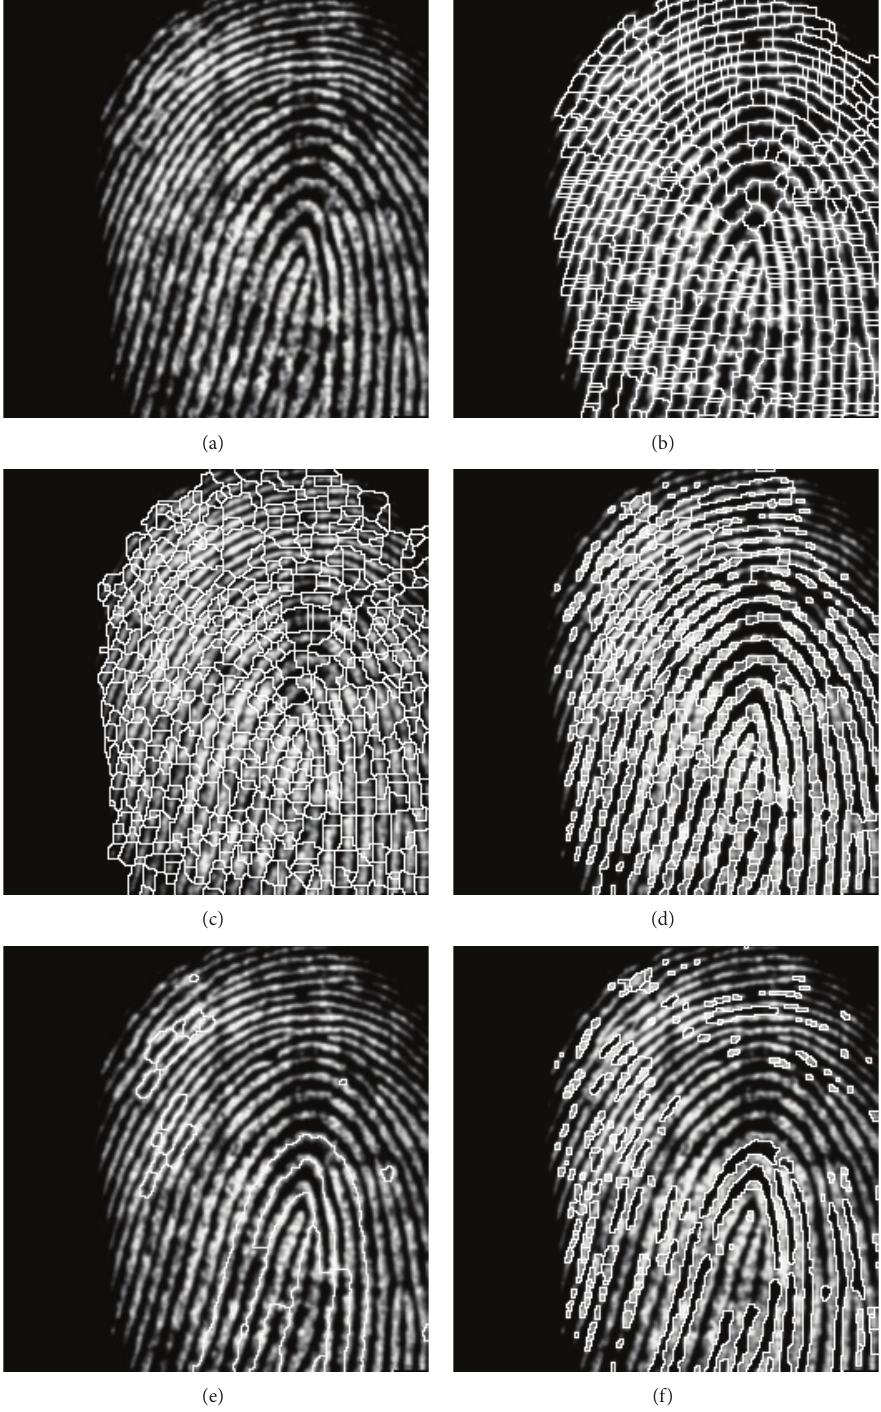
Figure 3: From left to right and from top to bottom: original image, result of traditional watershed algorithm, result of final multi-scale gradient algorithm, result of [4] algorithm, result of [15] algorithm, and result of the new